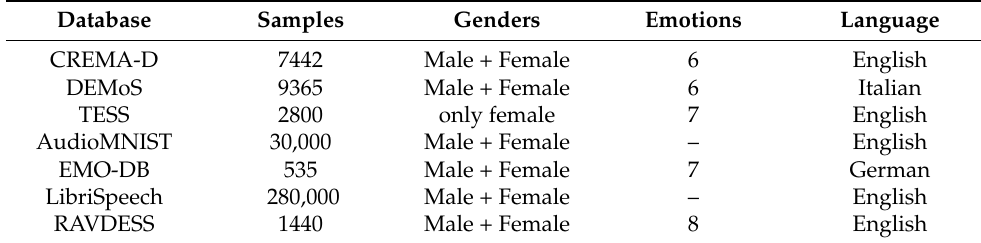
Table 1. Examples of different speech datasets, their content and